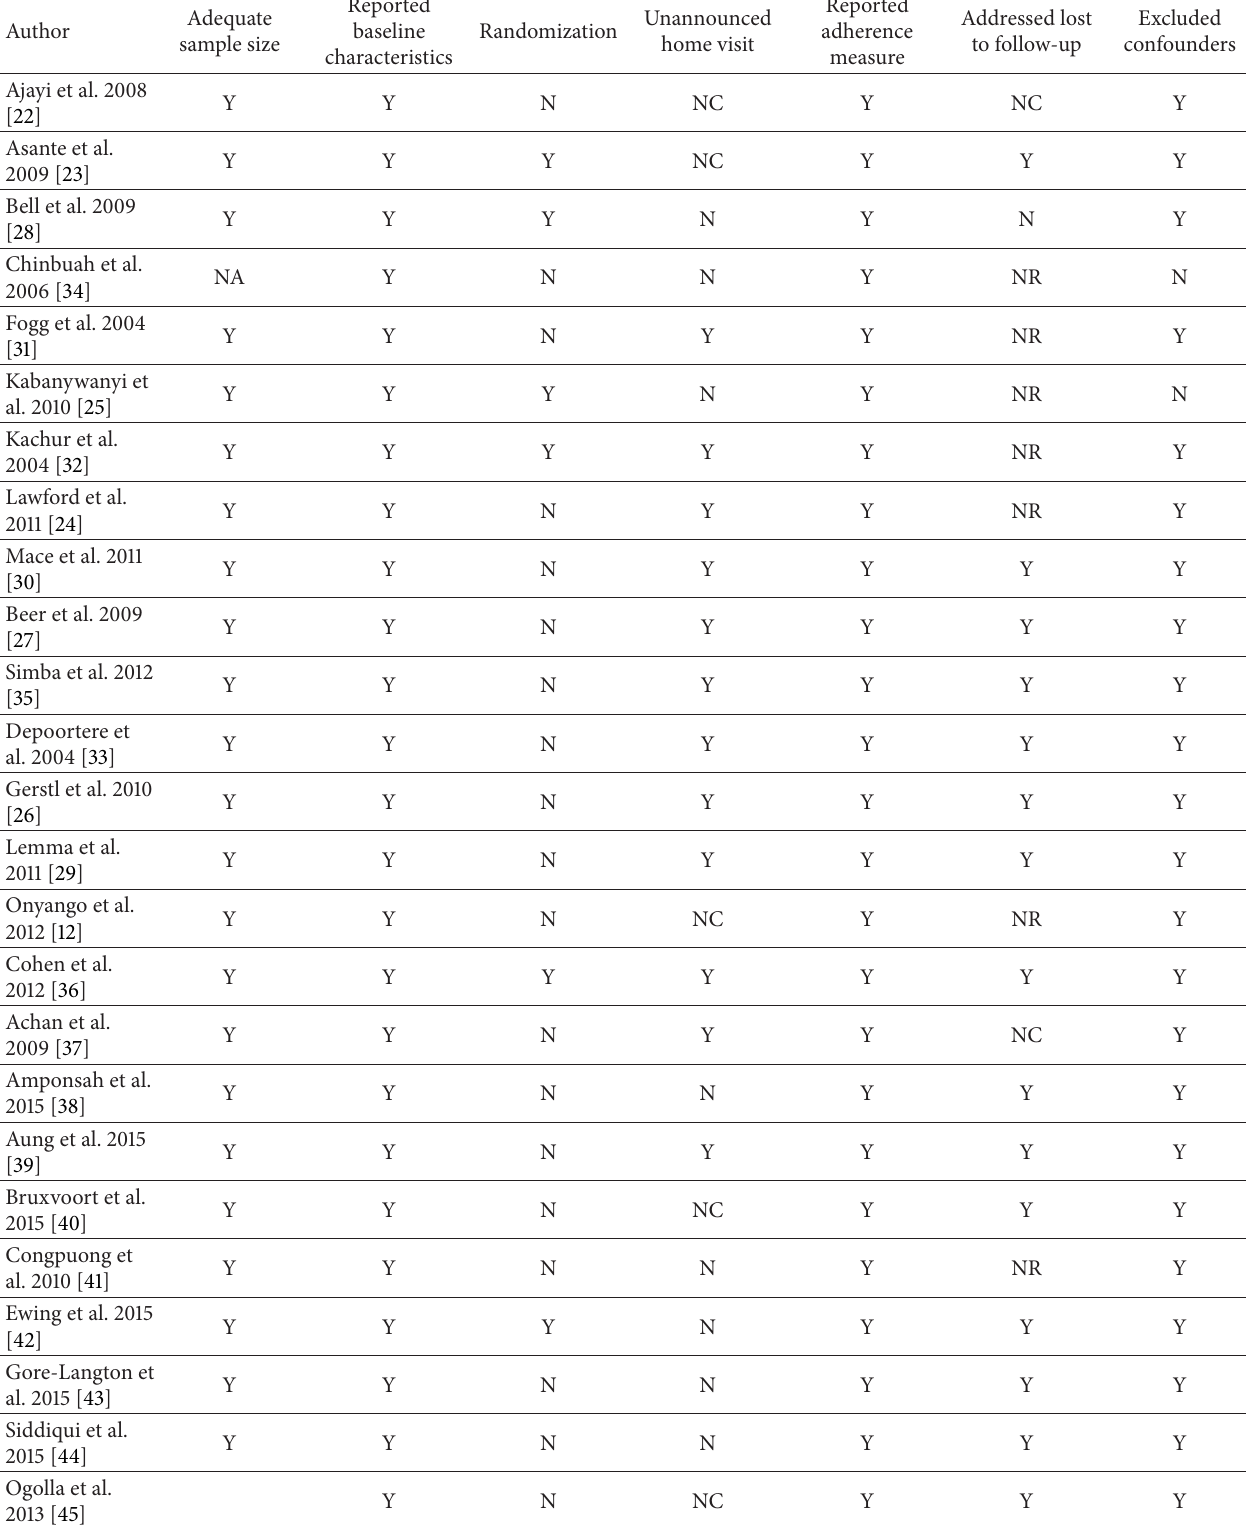
Table 2: Quality assessment of included